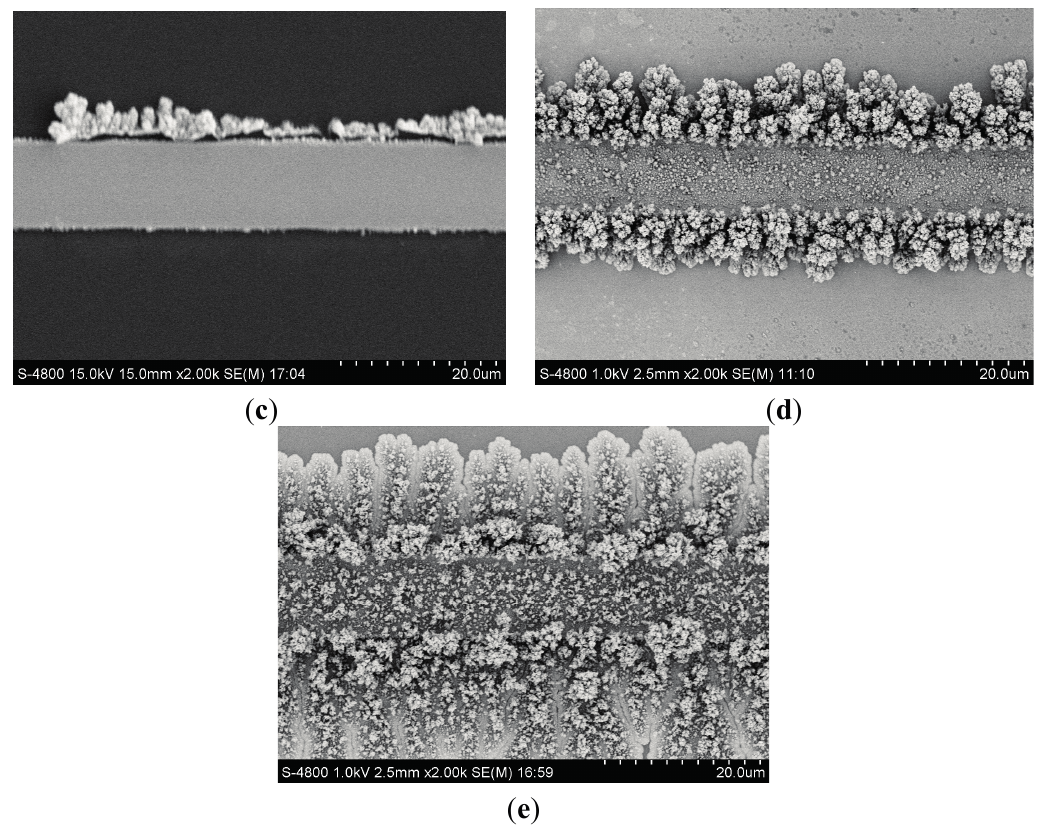
Figure 1. SEM images of palladium layer deposited under a fixed potential of ( a ) − 0.3 V; ( b ) − 0.4 V; ( c ) − 0.5 V; ( d ) − 0.56 V; ( e ) − 0.62